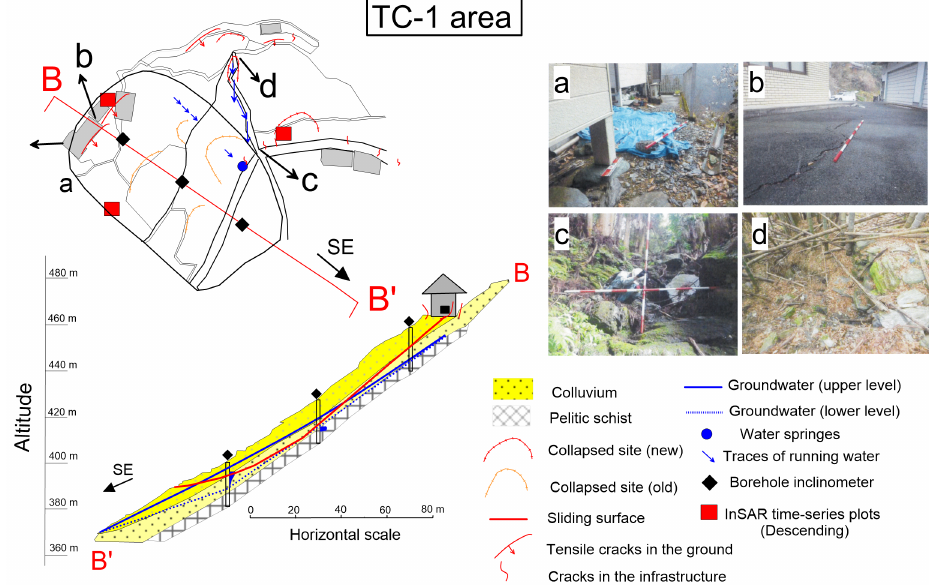
Figure 4. Diagram showing landslide movement in the TC-1 area corresponding to the surface damage caused to homes and infrastructure ( a , b ), ground truth observations ( c , d ), as well as water springs, with a geological cross-section B–B’ indicating the locations of the inclinometer boreholes that provided data on depth to the sliding surface and water